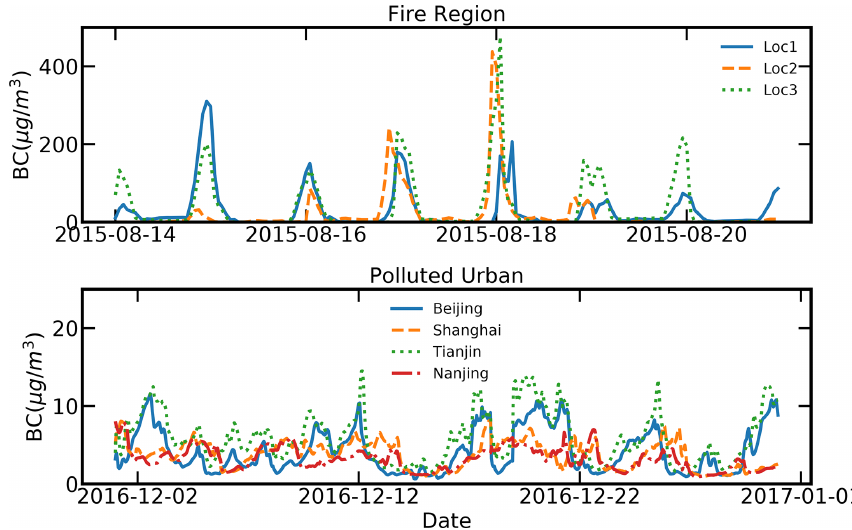
Figure 3. The time series of BC concentrations at typical sites in the northwest US and eastern